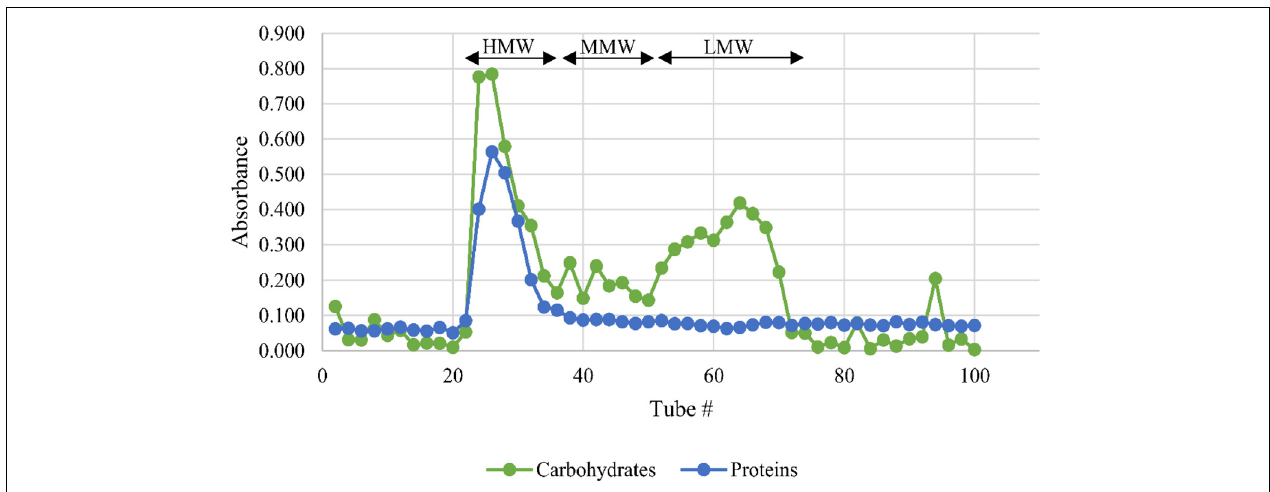
FIGURE 3 | Sephadex R (cid:13) G-50 fractionation of L. rhinocerus TM02 sclerotial cold-water extract. A total of 100 tubes (2.5 ml/tube) were collected. The carbohydrate and protein contents of each tube were determined and expressed as absorbance at 490 and 595 nm, respectively. The tubes were pooled into three fractions based on their molecular weight-range namely HMW, MMW, and LMW for high-molecular-weight, medium-molecular-weight, and low-molecular-weight fractions, respectively. HMW contained the bulk of proteins and carbohydrates. LMW contained low-molecular-weight carbohydrates and a small amount of proteins. MMW were constituted of the tubes between the HMW and LMW fractions.